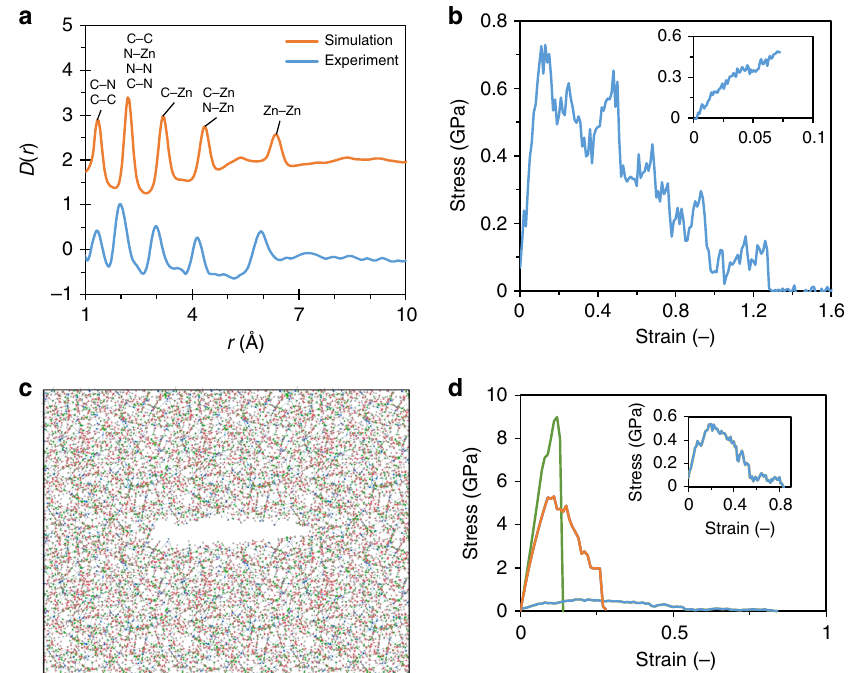
Fig. 1 Molecular dynamics simulations of ZIF-62 glass structure and mechanical properties. a Comparison between experimental 27 (blue) and simulated (orange) differential correlation function ( D ( r )) of ZIF-62 glass averaged over eight performed quenches. Data have been shifted vertically by + 2 for easier comparison. b Example of a stress ( σ ) vs. strain ( ε ) curve used in the estimation of the simulated ultimate strength (main fi gure) and modulus (inset). c Structural representation of an induced precrack in the glass network. Colored spheres represent carbon (red), hydrogen (gray), nitrogen (green), and zinc (blue). Cutoffs for bonds are 2.0 Å for C – C and C – N bonds, 3.0 Å for Zn – N bonds, and 1.5 Å for C – H bonds. d Simulated stress – strain curve of the precracked ZIF-62 glass (blue line, enlarged in inset) used in the estimation of fracture toughness. The green and orange lines represent stress – strain curves for disordered a -SiO 2 37 and calcium aluminosilicate 37 , respectively. Note that these simulations featured a slightly different crack-to-box ratio (~0.33) compared to that in this study (~0.41). Source data are provided as a Source Data fi Table 1 Comparison of mechanical properties of experimental and simulated ZIF-62 glasses. E (GPa) ν ( − ) K ε 0.5 ) γ (J m − 2 ) σ σ max (%) Ic (MPa m max (GPa) ZIF-62 glass (exp) 5.2 0.343 4.1 Estimated errors for elastic modulus ( E ), Poisson ’ s ratio ( ν ), fracture toughness ( K Ic ), fracture surface energy ( γ ), strength ( σ max ), and strain at maximum stress ( ε σ ) are 0.9GPa, 0.035, 0.009MPa max m 0.5 , 0.11Jm − 2 , 0.087GPa, and 6.7%, respectively, for MD simulations and 0.3GPa, 0.001, 0.019MPa m 0.5 , 0.31Jm − 2 , 0.002GPa, and 0.07%, respectively, for experiments. Source data are provided as a Source Data fi le.